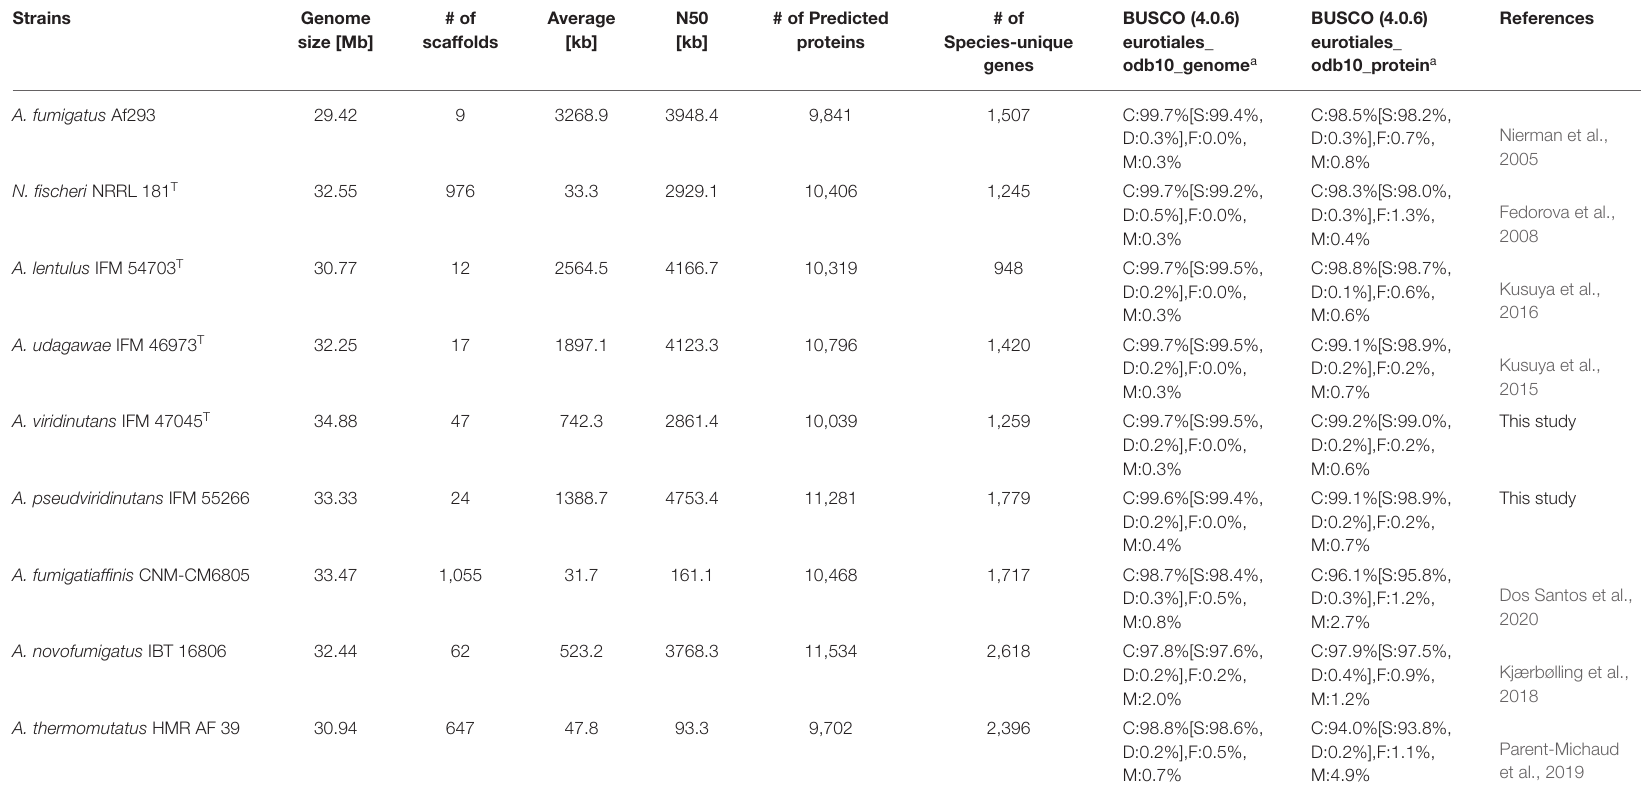
TABLE 1 | Genome characteristics and assembly of Aspergillus section Fumigati